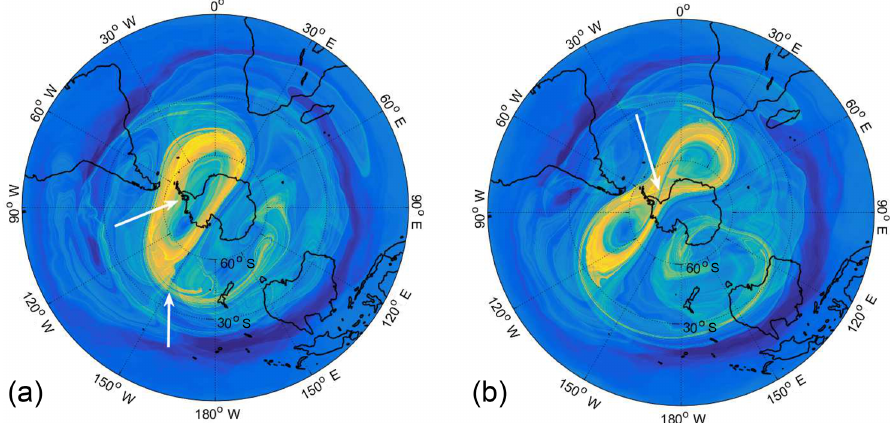
Figure 4. Stereographic projection of the M function calculated using τ = 15 on the 850K isentropic level for (a) 22 September 2002 at 00:00:00UTC and (b) 24 September 2002 at 00:00:00UTC. Filamentation phenomena and hyperbolic trajectories (marked with white arrows) are nicely captured in these simulations both in the interior and the exterior of the SPV. Observe how the vortex breakdown on 24 September occurs when, in the interior of the vortex, a HT allows the transport and mixing of parcels across the barrier.